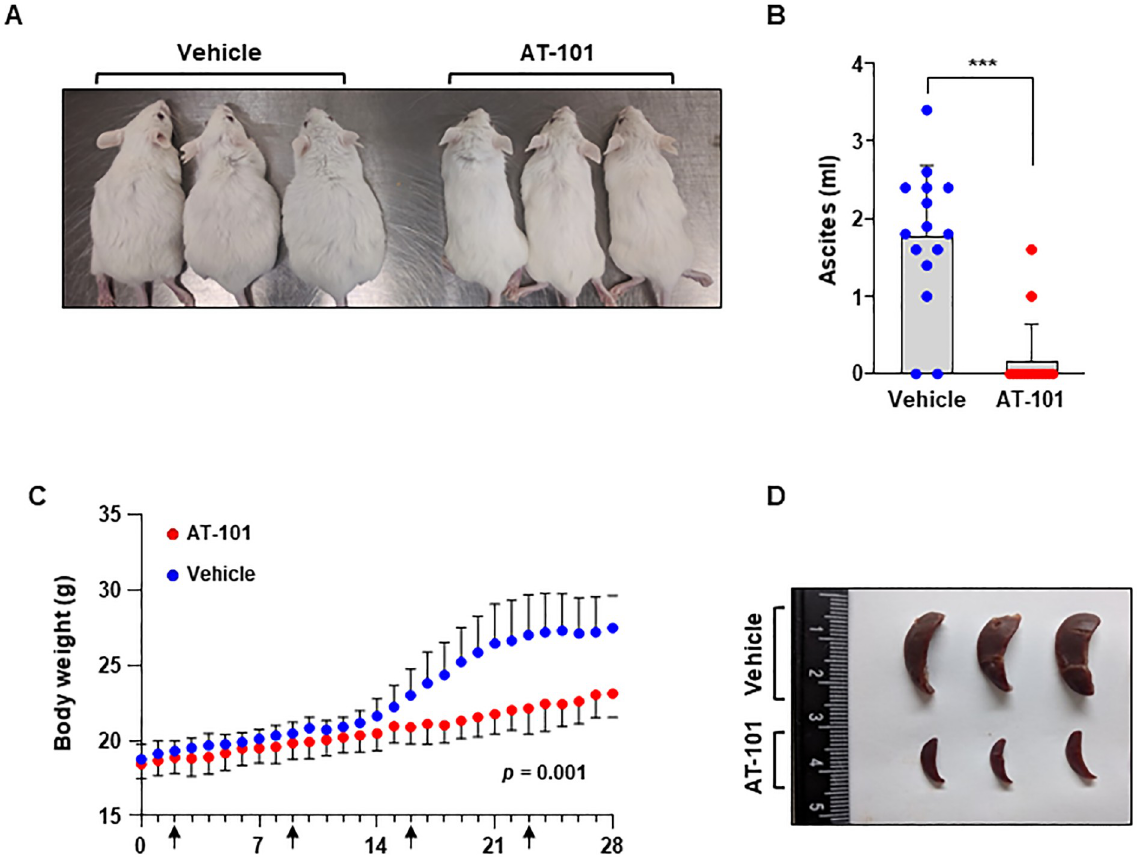
Fig 8. MCL-1 inhibitor treatment prevents KSHV + BCBL-1-mediated tumor formation in NOD/SCID mice. (A) BCBL-1 cells were injected intraperitoneally into NOD/SCID mice, followed by treatment with AT-101 once a week. Mice were euthanized using CO 2 at 6 weeks after cell injection. Animals treated with AT-101 did not develop the distention observed in vehicle-treated animals. (B) After 28 days, mice were sacrificed and the volume of ascites fluid was measured. The number of dots in ascites volume represents the number of sacrificed mice. Error bars represent the SEM for two independent experiments. ��� , p < 0.0005. (C) Body weight of DMSO or AT101 treated mice was recorded daily. p = 0.001 (D) The spleens in AT-101-treated animals were smaller than those in vehicle-treated animals.